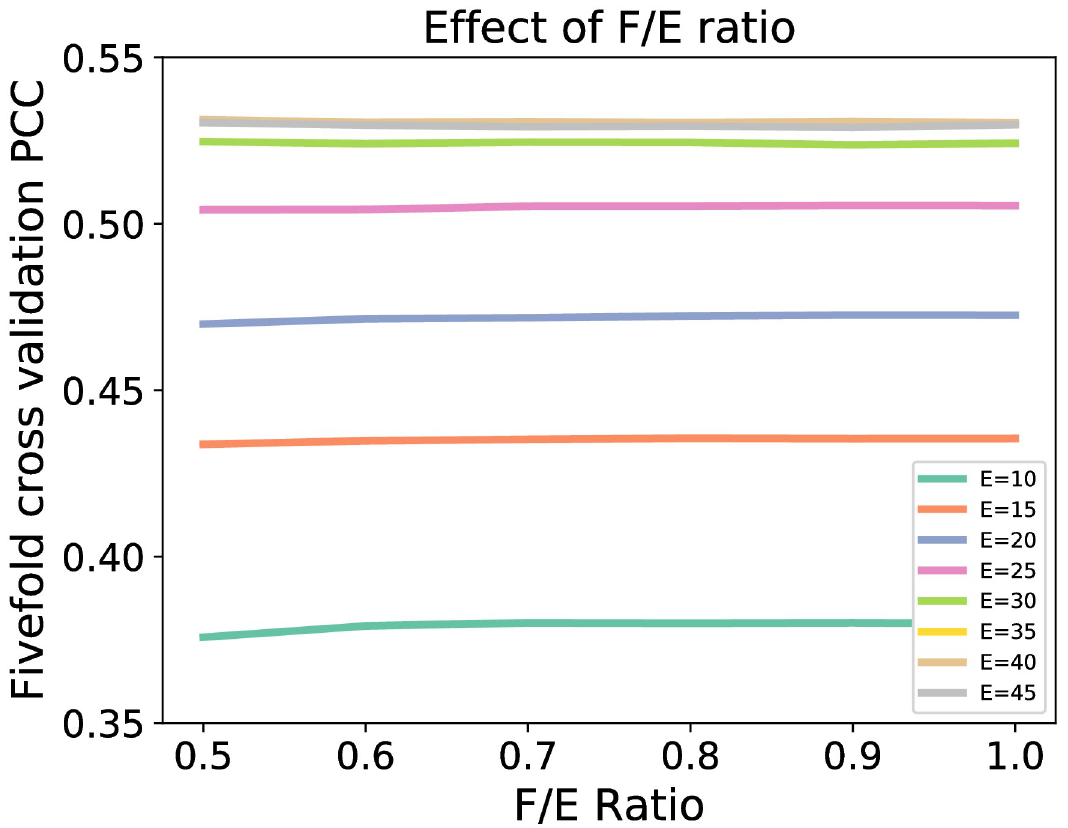
Fig 3. Effect of F/E ratio on RF using the topological features from all four elements and bin size of 0.15 Å .